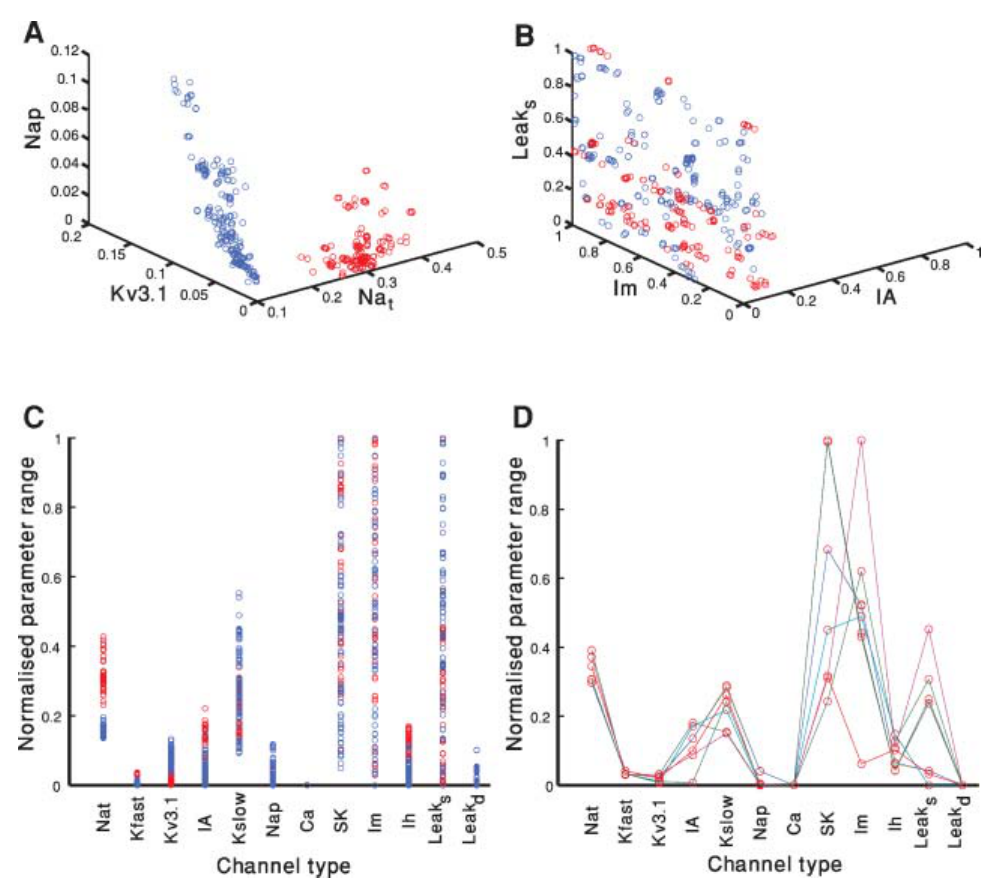
Figure 5. Parameter values of acceptable solutions . A– B . Each of the 300 parameter sets at the final iteration of a fitting attempt that has an error of less than 2 SD in each objective is represented as a circle. The circle is plotted at the point corresponding to the normalized value of the selected channel conductance. Red circles represent models of the accommodating neuron and blue represent models of the fast-spiking neuron. Plotted are the results of two out of the three repetitions of the fitting attempt shown in Figure 3 . (A) The channels selected were: Na t , Na p , Kv3.1. (B) The channels selected were: Leak soma , I m , I A . (C) As in A and B , but here each of the parameter set for each of the 300 acceptable solution at the 1000th generation is depicted as a circle on a single dimensional plot. The circle is plotted at the point corresponding to the normalized value of the channel conductance. Note that even when projected onto a single dimension the two electrical behaviors occupy separate regions for some of the channels. (D) A subset of seven of the parameter sets of the accommodating behavior displayed in red in B is depicted. Lines connect each set of parameters that correspond to an acceptable solution. Thus, each individual line represents the full parameter set of a single model.